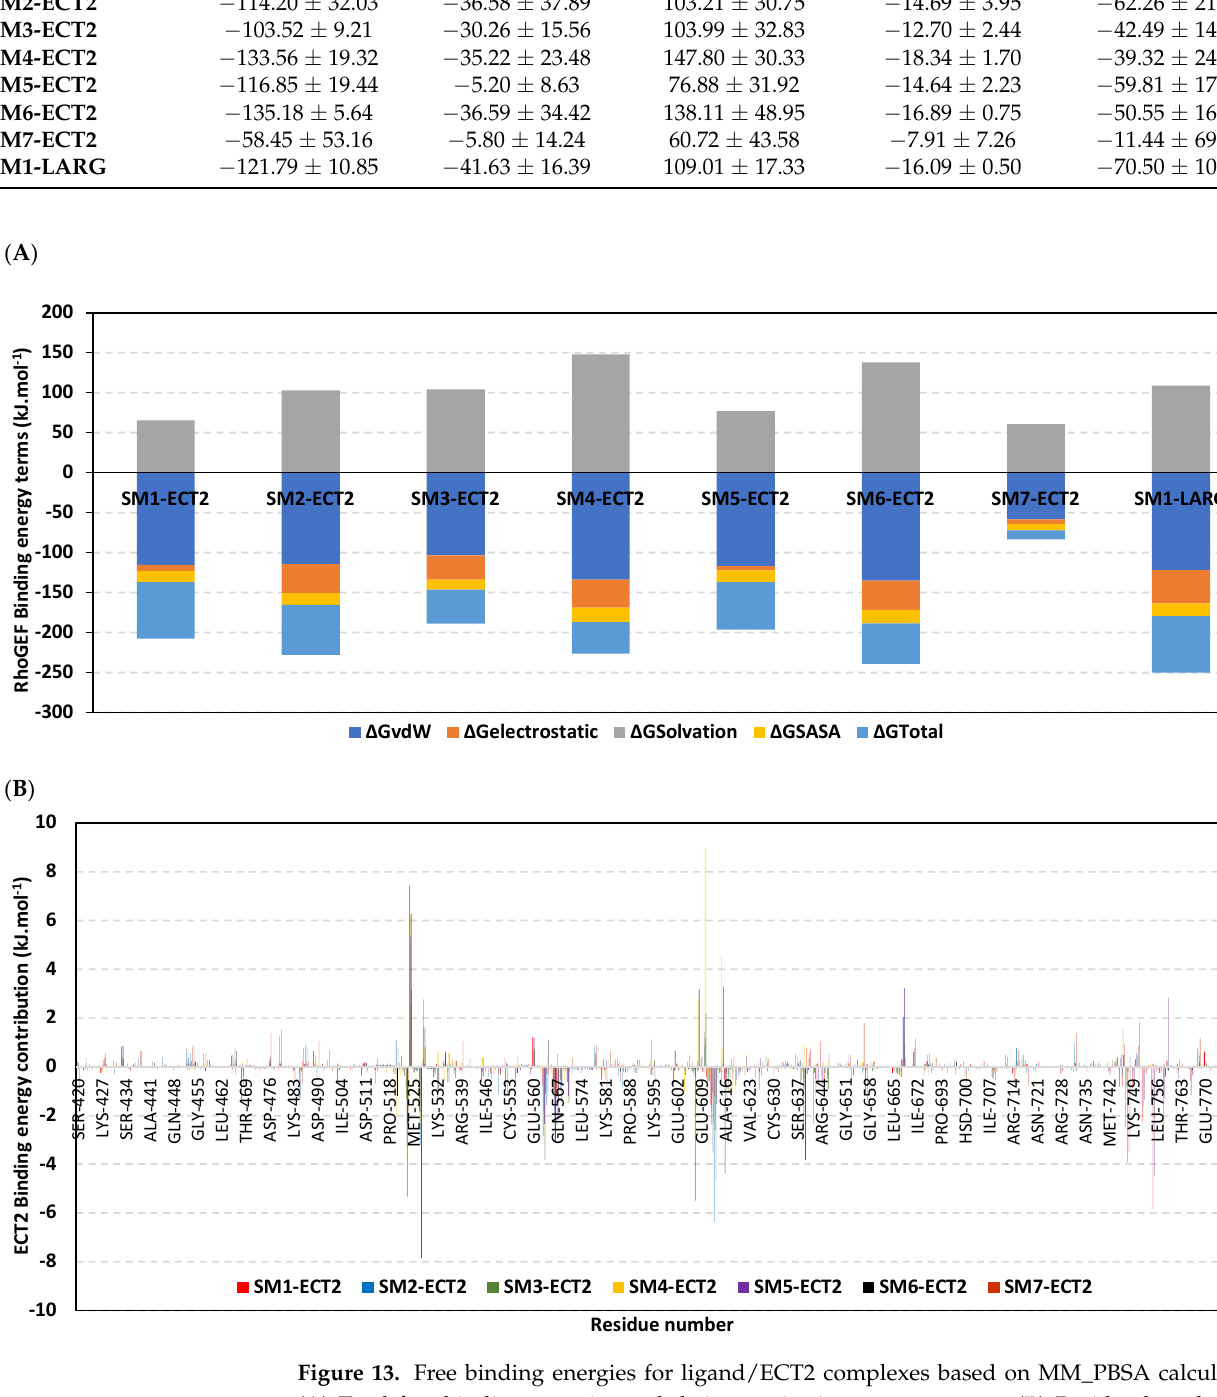
Figure 13. Free binding energies for ligand/ECT2 complexes based on MM_PBSA calculations. ( A ) Total free binding energies and their constituting energy terms. ( B ) Residue-based energy contributions within the free binding energies. Table 2. Total free binding energy (ΔG ± SE) for ligand/RhoGEF systems via MM_PBSA approach.